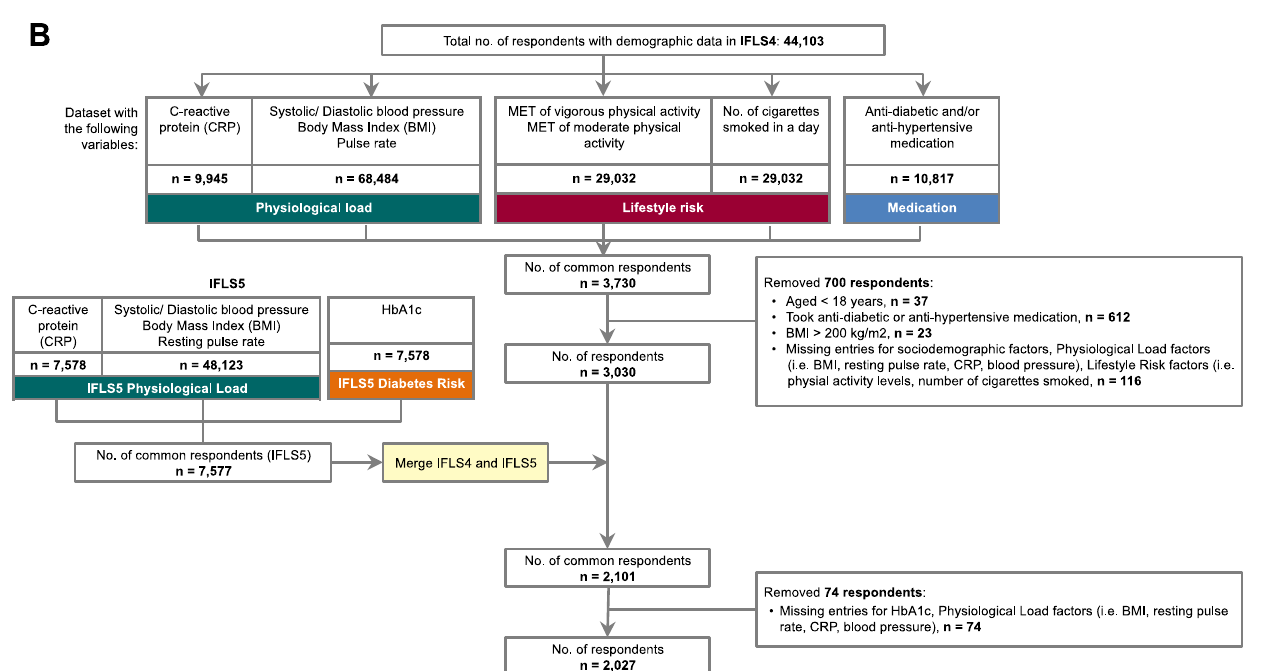
Figure 4. Flow charts of the study sampling for Model A ( A ) and Model B ( B ). Note: The number of respondents removed based on specific exclusion criteria do not add up to the total number removed, due to respondents who met multiple exclusion criteria.